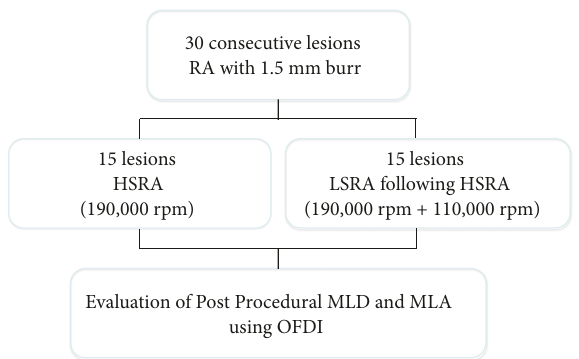
Figure 3: Study Flowchart of Human Studies. 30 lesions in patients who underwent rotational atherectomy (RA) with 1.5 mm burr from June 2013 to January 2017. 15 lesions were ablated at 190,000 rpm, defined as high-speed RA (HSRA), and 15 lesions were ablated at 190,000 rpm followed by 110,000 rpm, defined as additional low-speed RA (LSRA) following HSRA. Post-RA minimum lumen diameter (MLD) and minimum lumen (MLA) were measured immediately afterwards by optical frequency domain imaging (OFDI).